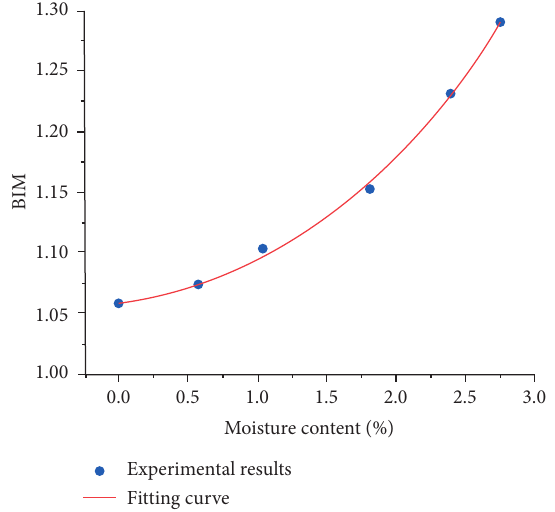
Figure 10: Relationship between BIM and moisture content. Table 6: Fitting functions and their related R 2 for determining the best relation between BIM and moisture content. Fitting function R 2 Linear 0.93158 Polynomial 0.99468 Exponential fit 0.99833 Table 7: Classification of bursting liability of sandstone with different water content under freeze-thaw